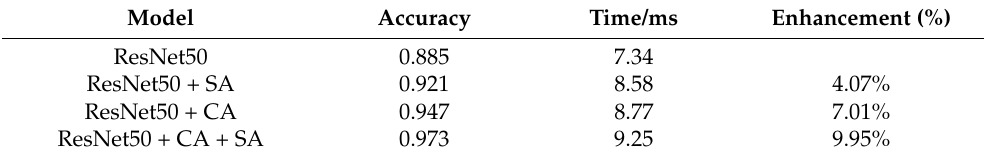
Table 3. Comparison of accuracy and calculation time of different models.